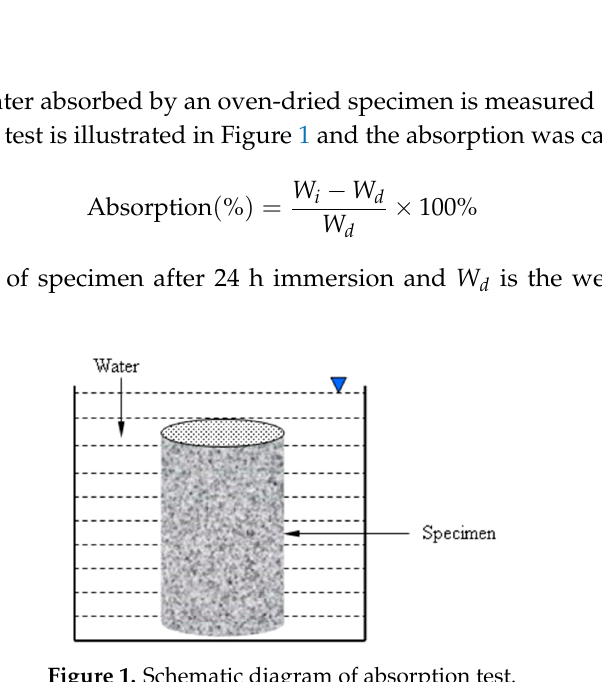
Figure 1. Schematic diagram of absorption test.